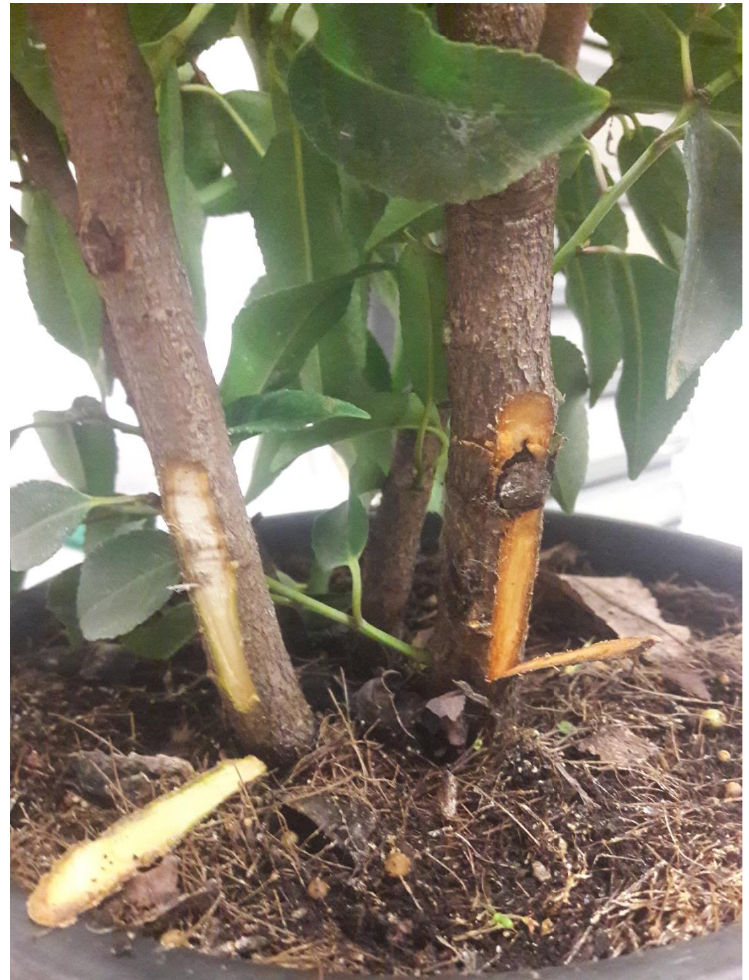
Figure 6. Pathogenicity test with the isolate DAFE SP16-21 of Dactylonectria macrodidyma . On the left: healthy control. On the right: reddish brown symptoms.